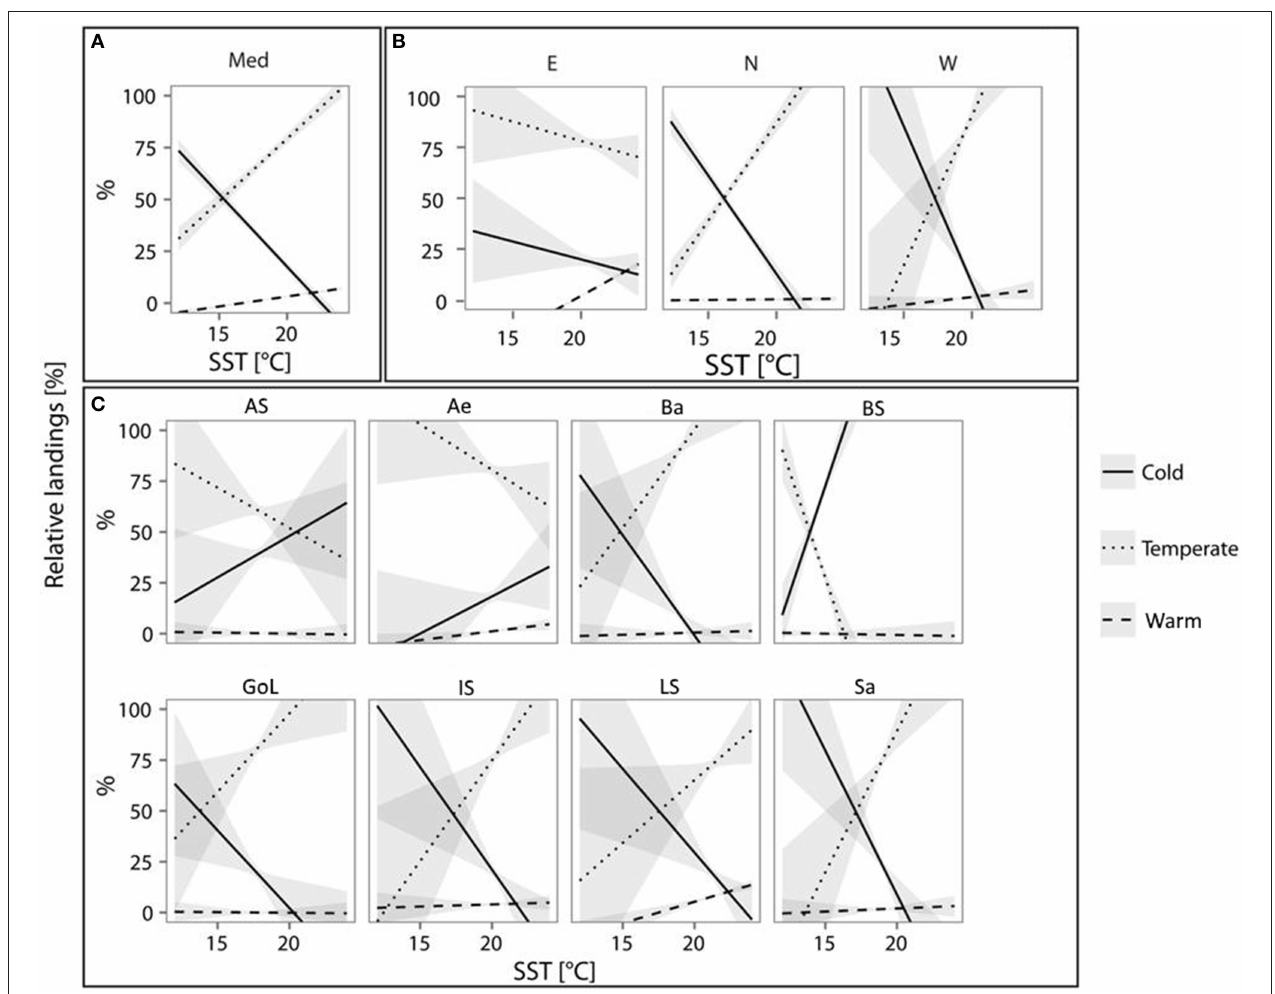
FIGURE 4 | Landings—SST relationship for each thermal affinity group, at different spatial scale of analysis. (A) Mediterranean basin, (B) macroareas (C) FAO areas; AS, Adriatic Sea; Ae, Aegean Sea; Ba, Balearic Sea; BS, Black Sea; GoL, Gulf of Lion; IS, Ionian Sea; LS, Levantine Sea; Sa, Sardinia; landings are expressed as percentage of total